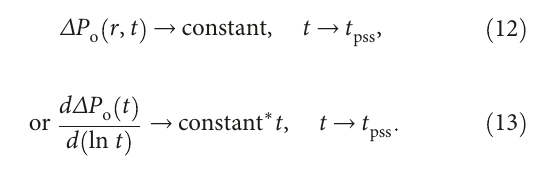
Figure 5: This fi gure shows the log-log plot of drawdown from closed system. It shows that the pressure responses ( Δ P P − P ) and the pressure derivative responses ( Δ P i wf model and fl at model under single-phase fl ow condition are the